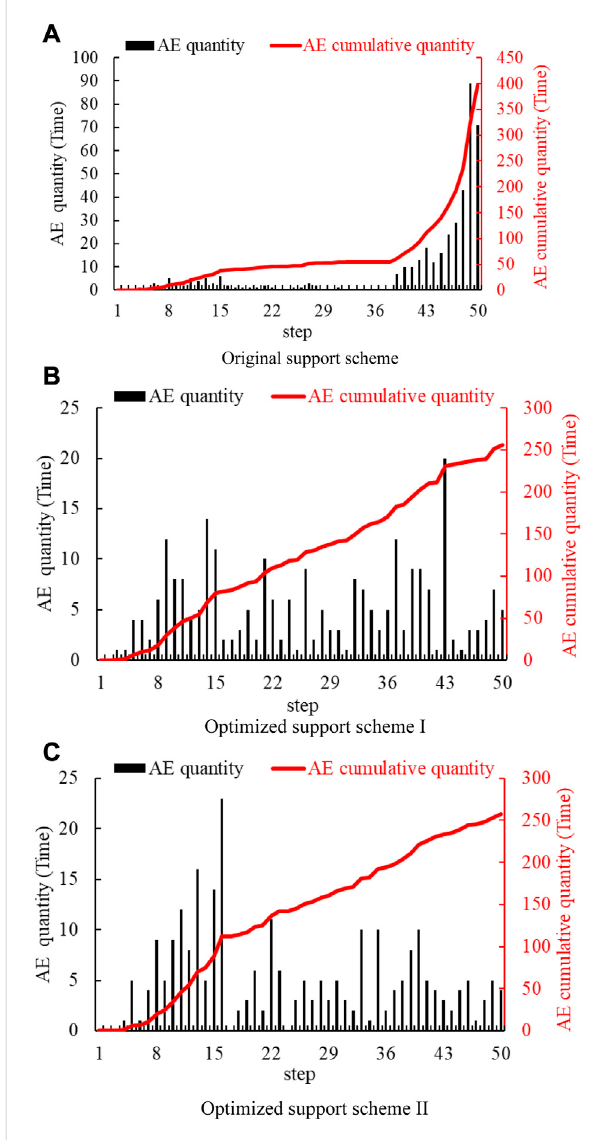
FIGURE 15 Variation trend of the AE quantity under various